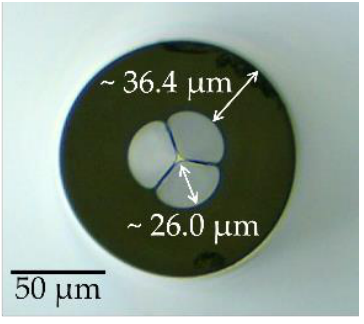
Figure 1. Microscope photograph of the SCF cross-section.